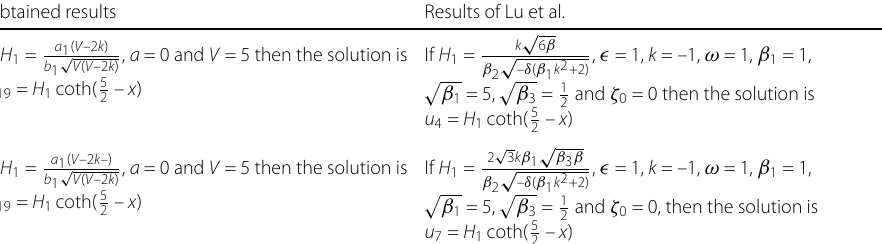
Table 3 Comparing the results of Lu et al. [25] with our results Obtained results Results of Lu et